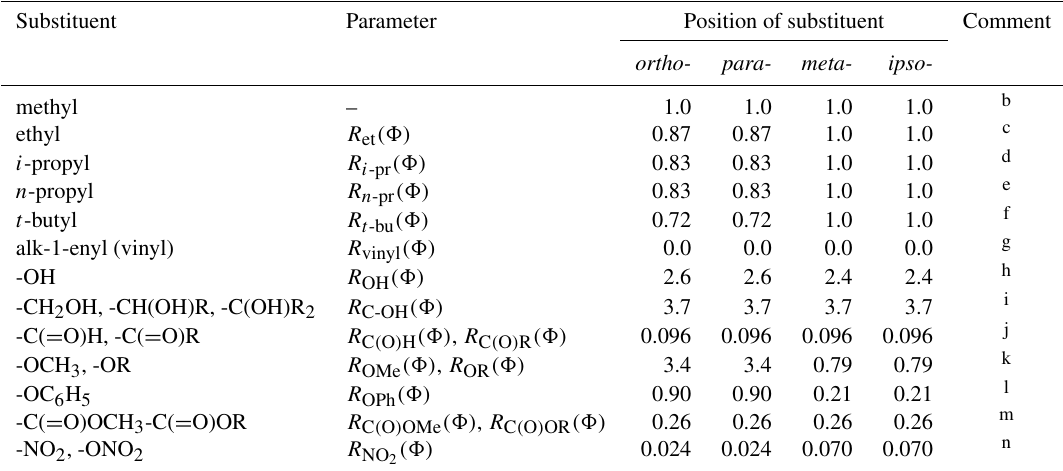
a Applied to values of F ( (cid:56) ) in Table 3 for each component group, and to k b Factors are 1.0 by definition. c Based on optimization to data for ipso . ethylbenzene, o -ethyltoluene, m -ethyltoluene and p -ethyltoluene. Use of a temperature dependent factor, R et (o - ) = R et (p - ) = 0 . 029exp ( 1014 /T) , is provisionally suggested, where the pre-exponential factor is based on that determined for the i -propyl group (see comment d). d Based on optimization to data for i -propylbenzene, and p -cymene (4- i -propyltoluene). Use of a temperature dependent factor, R i -pr (o - ) = R i -pr (p - ) = 0 . 029exp ( 1000 /T) , allows observed preferred temperature dependence of k for p -cymene to be recreated (see Sect. 3.1.2). e Provisionally assumed equivalent to i -propyl group adjustment factor, although a much lower factor (0.62) would recreate the reported k for n -propylbenzene. Use of a temperature dependent